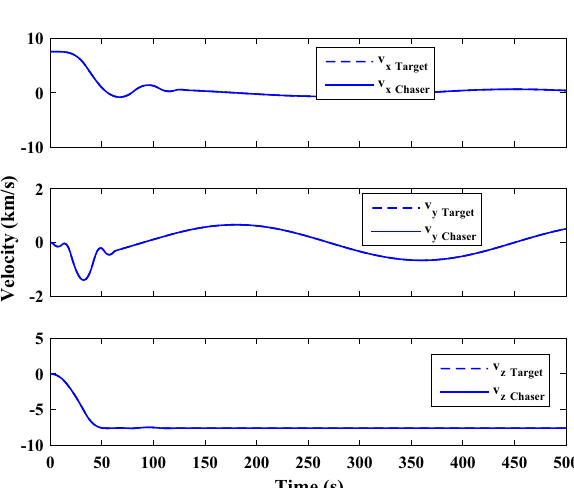
Figure 61. Scenario III: relative position error (in desired frame).